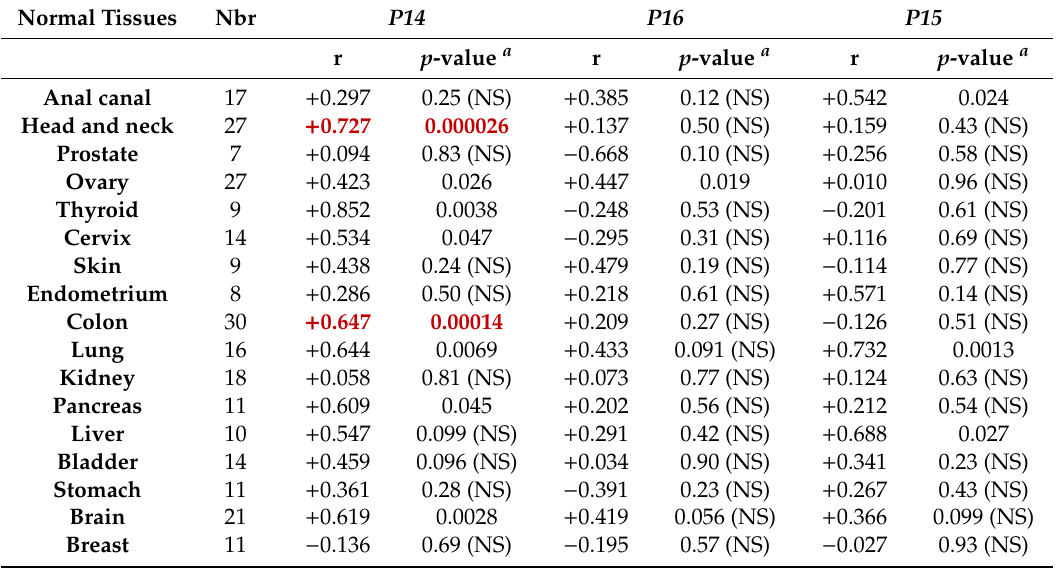
Table 1. Correlations between ANRIL and P14, P15 and P16 mRNA expression levels in the series of normal